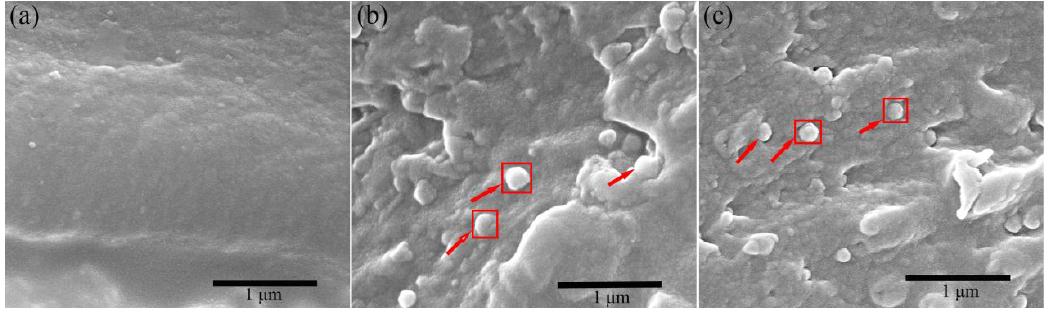
Figure 7. The fracture surface SEM image of ( a ) neat PEN, ( b ) O -Fe 3 O 4 /FePc/ H -PEN, and ( c ) E -Fe 3 O 4 /FePc/ H